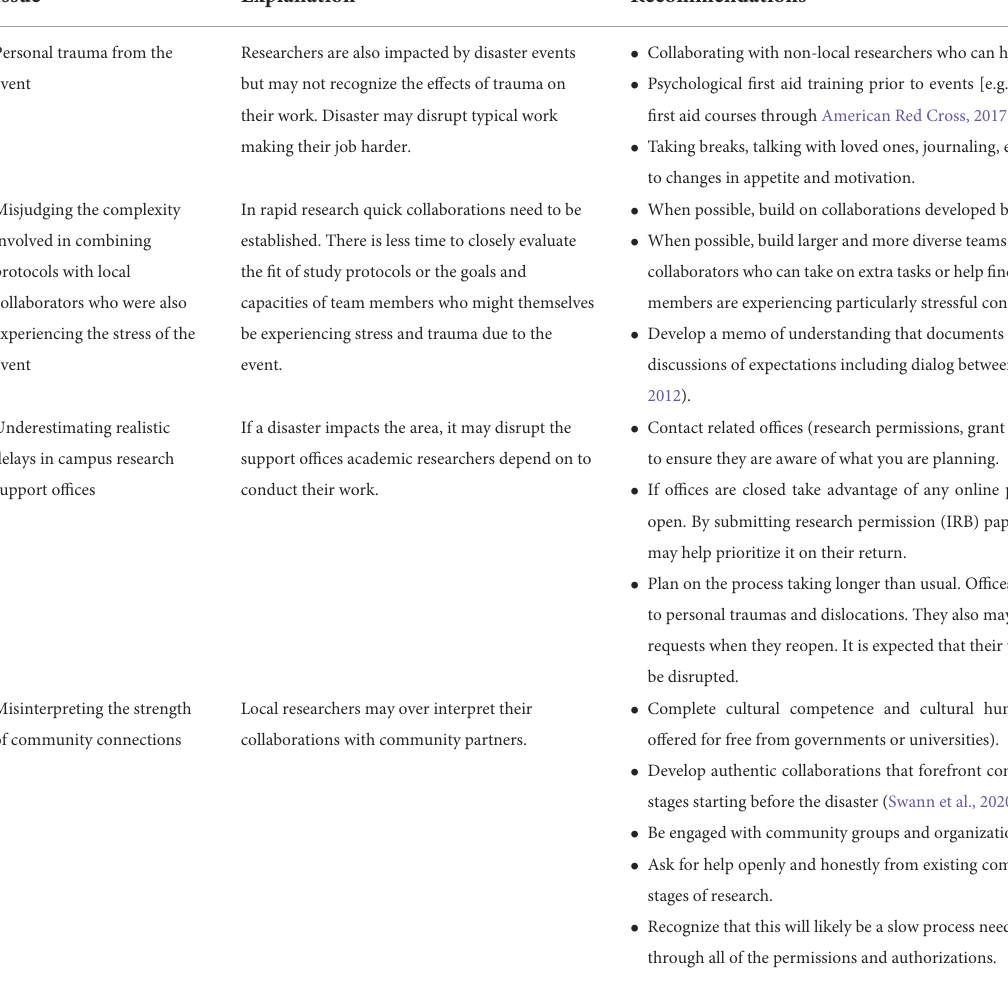
TABLE 1 Addressing unanticipated challenges associated with rapid research as a local